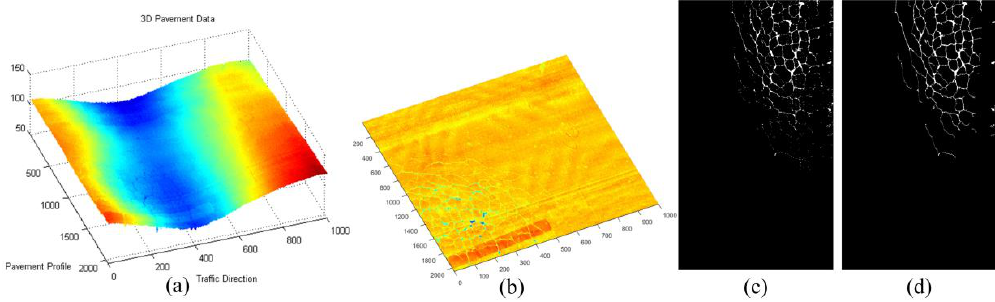
Figure 13. Sparse components and the corresponding pavement alligator cracks information, ( a ) 3D pavement data, ( b ) the corresponding sparse components, ( c ) crack information, ( d ) crack ground pavement data; ( b ) the corresponding sparse components; ( c ) crack information; ( d ) crack ground truth information. truth Table 1. Buffered Hausdorff scores of test data in Figure 11–13 Crack Types